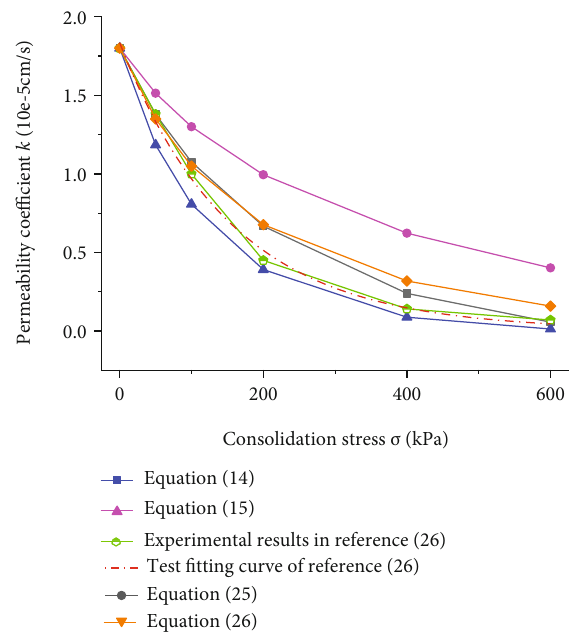
Figure 6: Relation curves between the permeability coe ffi cient and consolidation